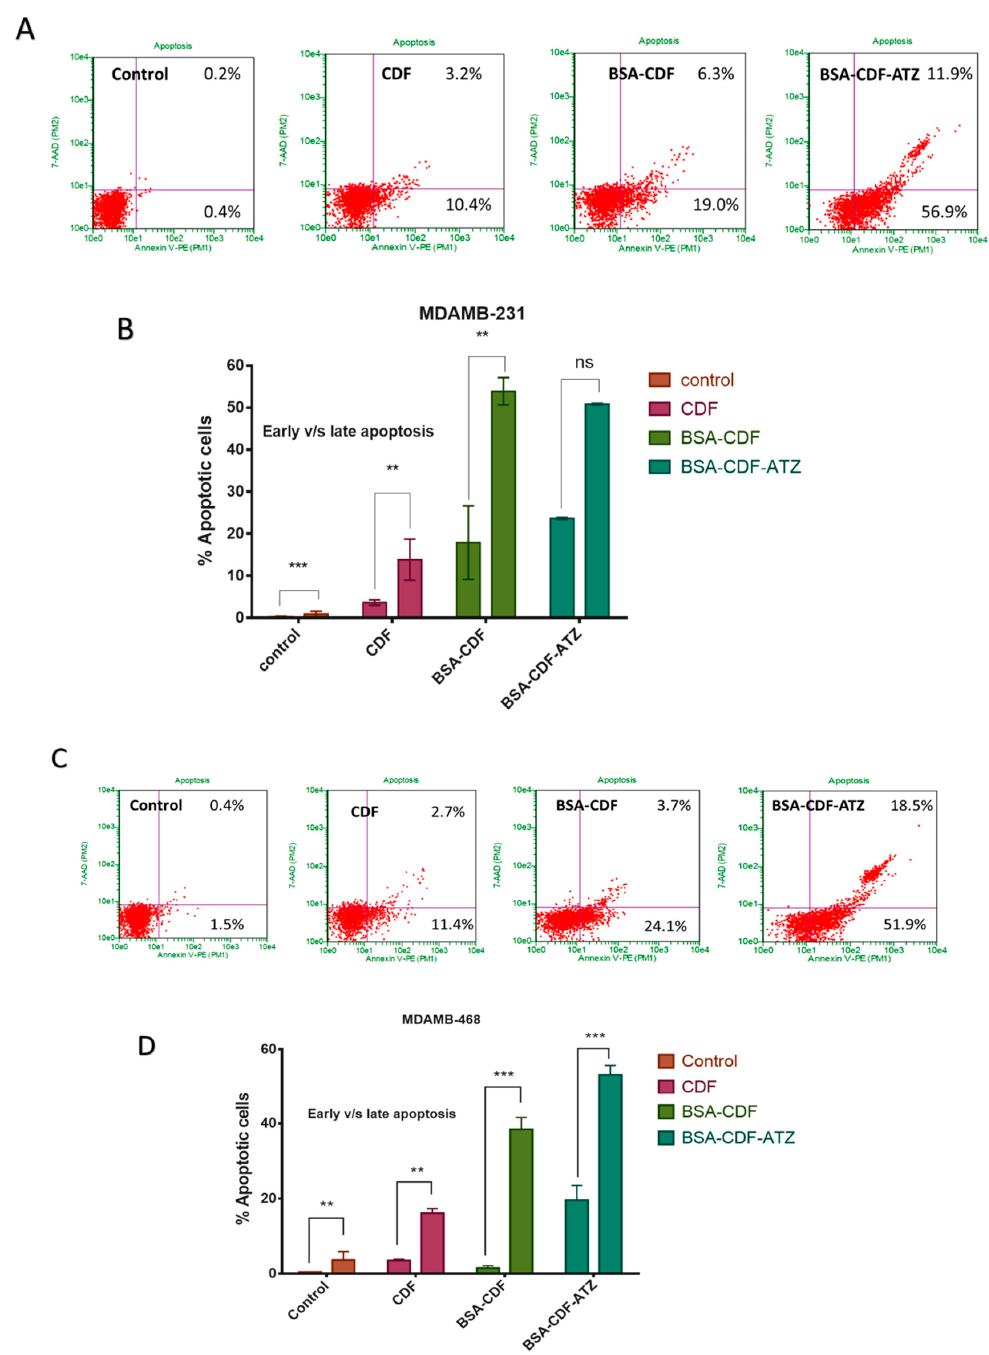
Figure 9. Apoptosis assay studies and their graphical interpretations in ( A , B ) MDA-MB-231; ( C , D ) MDA-MB-468 for BSA-CDF-ATZ. The targeted nanoparticles have illustrated a better cell killing in the tumor cells in both cell lines. Experiments were performed in triplicates; results are shown mean ± SD; **P ≤ 0.01; ***P ≤ 0.001.